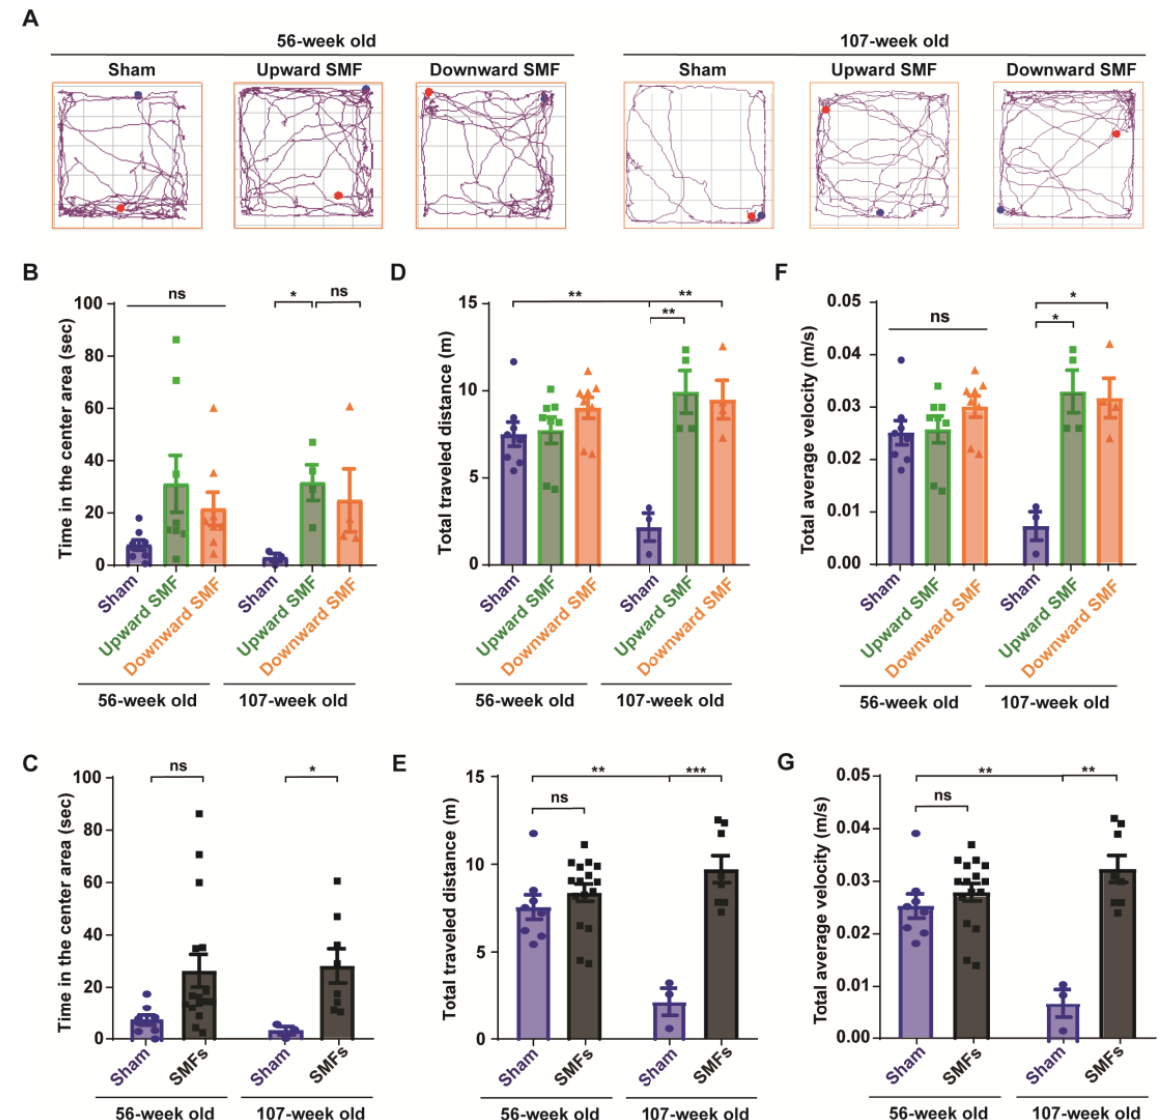
Figure 3. Open field test shows that SMFs could significantly improve the exploratory and locomotive activities of aged mice. ( A ) Representative trajectories of mice in the open field test at 56 and 107 weeks old. The blue and red points show start and end points, respectively; ( B , C ) time in the center area, ( D , E ) total traveled distance, ( F , G ) total average velocity were recorded and analyzed in a blinded way. Mice in the upward or downward SMF exposure groups were analyzed separately ( B , D , F ) or grouped together as SMF group ( C , E , G ). n = 8 mice for the sham, upward SMF or downward SMF group in the beginning of the experiment. Values were expressed as means ± SEM. * p < 0.05, ** p < 0.01, and *** p < 0.001 by Student’s t -test. ns, no significance.